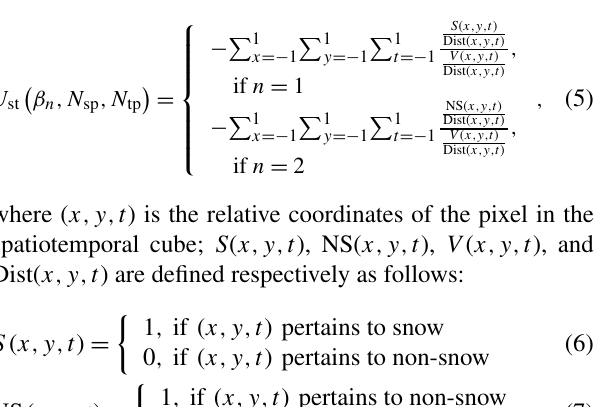
gaps still exist, the cubic neighborhood is temporally and spatially expanded in the next